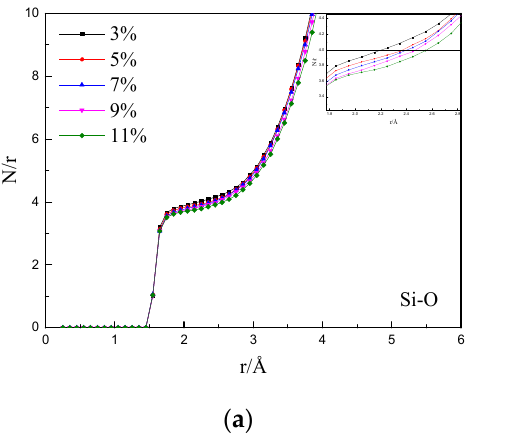
Figure 8. The s imulation results of CaF 2 content at 9% ( a ) radial distribution function and ( b ) coordination number function.